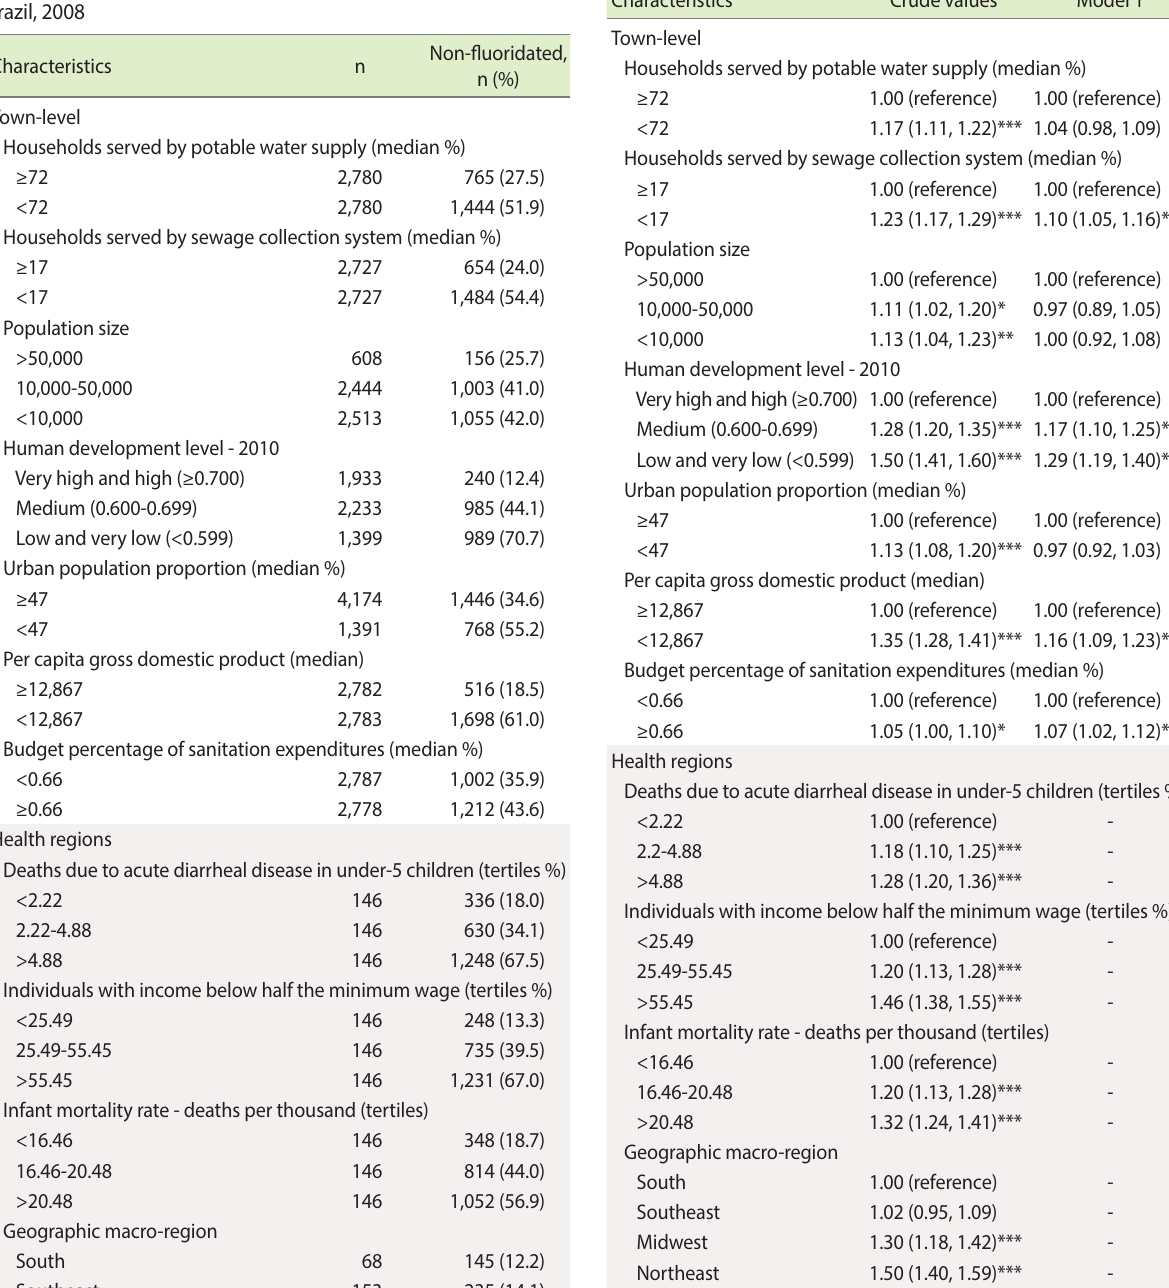
Table 2. Crude and adjusted values for associations between lack of water fluoridation provision and municipality and health